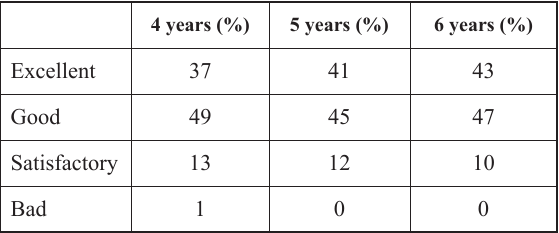
Table 1. Results of posture assessment by age of subjects